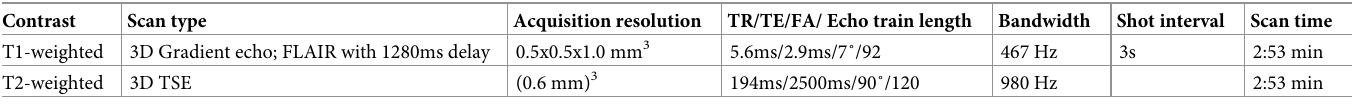
Table 2. Cartesian iymaging parameters.